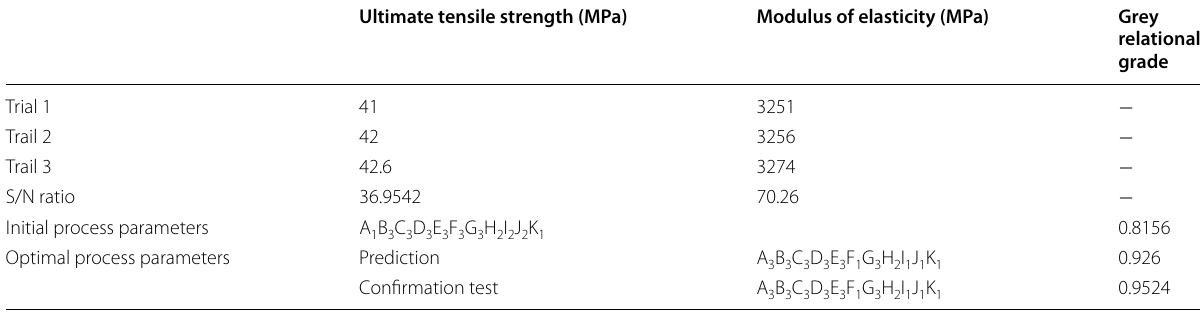
Table 6 Results of confirmation experiments